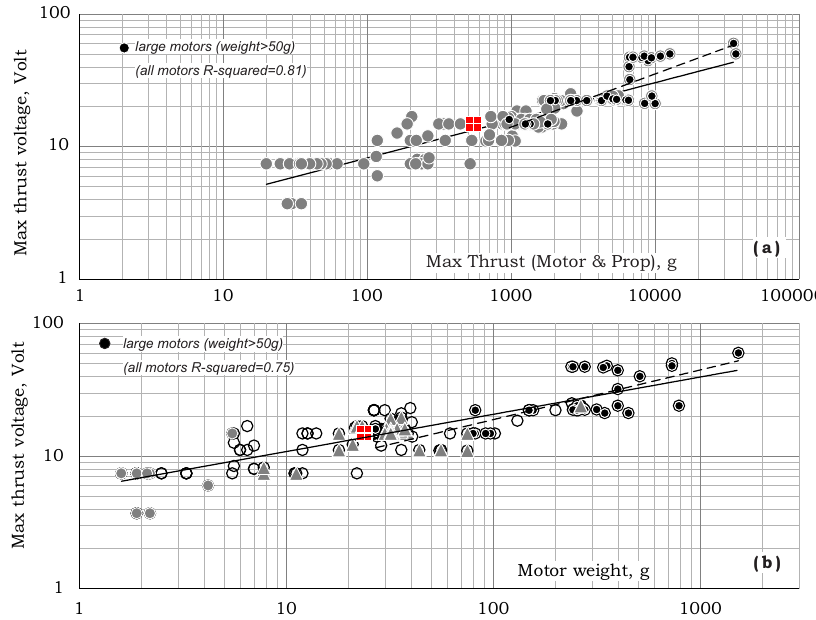
Figure 8. Motor voltage design trends, [17,18]. Full line: all motors; Dashed line: large